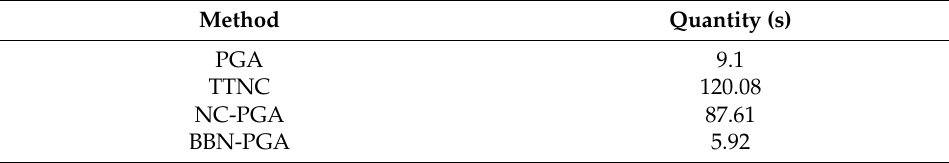
Table 3. Running time of different PE compensation methods.